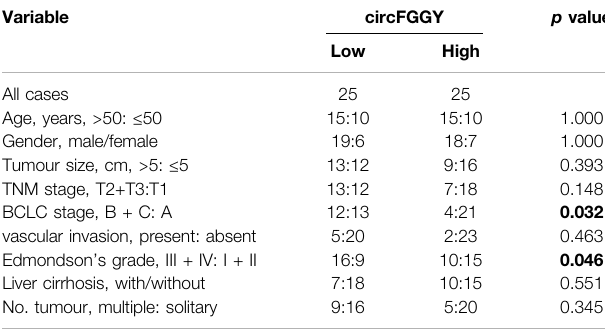
TABLE 1 | Association between circFGGY expression and clinical characteristics of hepatocellular carcinoma patients. Variable circFGGY p